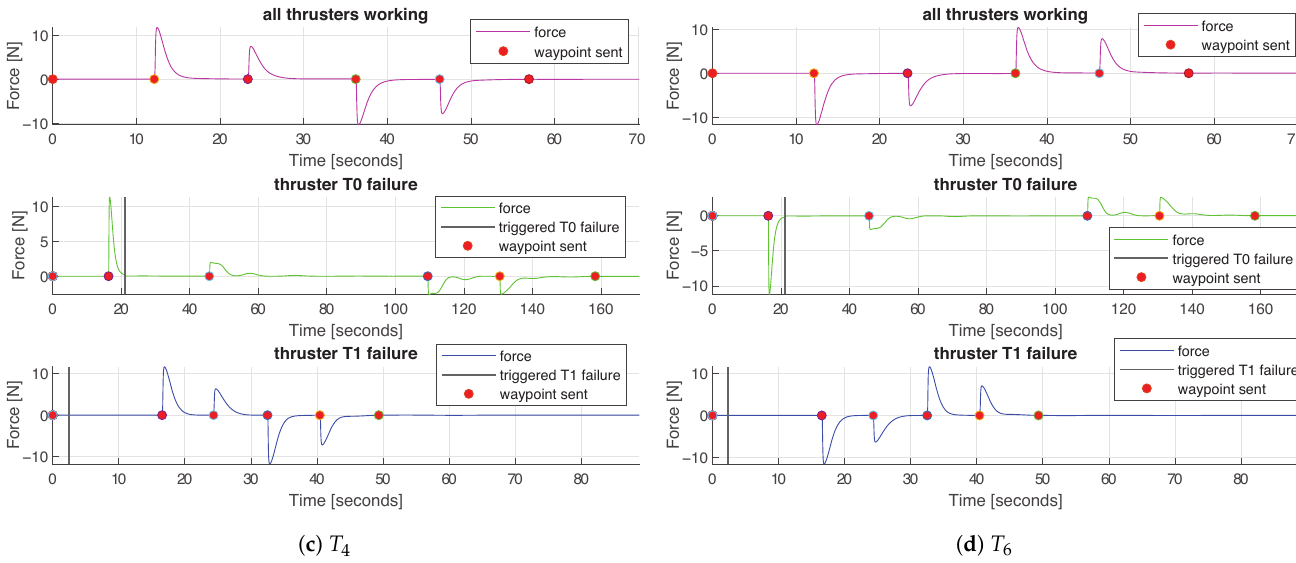
Figure 11. Forces produced by thrusters in charge for surge movement in all three experiments. Purple graphs represent the I test, green the II and blue the III . The time instance when each waypoint is sent is depicted with a red circle, and the moment of the thruster failure is depicted with a vertical black line.